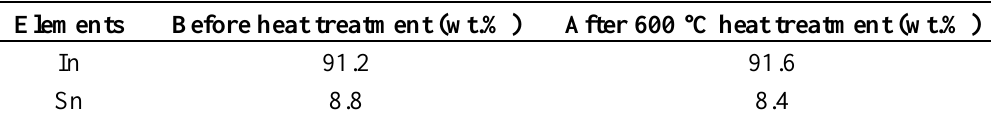
Table 1. Composition ratios of ITO nanoparticles obtained from TFT-LCD scraps by ICP